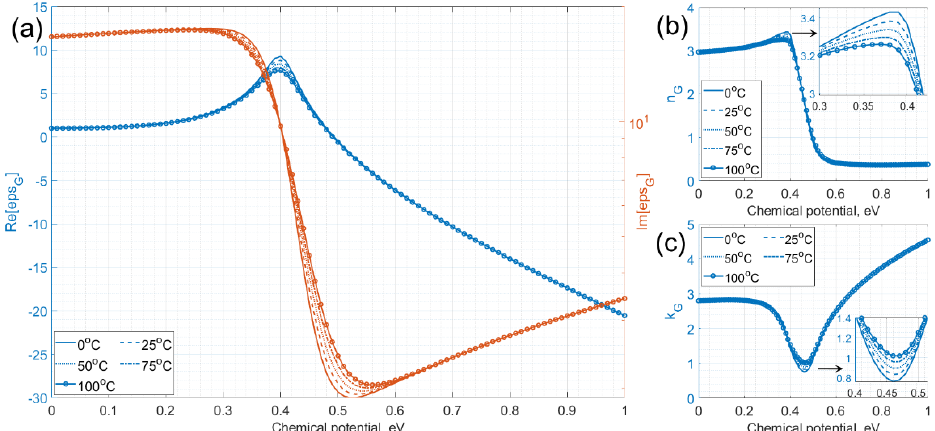
Figure 4. ( a ) Real (blue curves) and imaginary (red curves) parts of the permittivity, ( b ) refractive index and ( c ) extinction coefficient as a function of the temperature from various publications ( 𝜆 = 1.55 µ m, 𝑡 (cid:3008) = 0.34 nm, 𝜇 (cid:2913) = 0 ÷ 1 eV, Г = 8e13 s − 1 , T = 0 ÷ 100 °C). ( λ = 1.55 µ m, t G = 0.34 nm, µ c = 0 ÷ 1 eV, Γ = 8e13 s − 1 , T = 0 ÷ 100 ◦